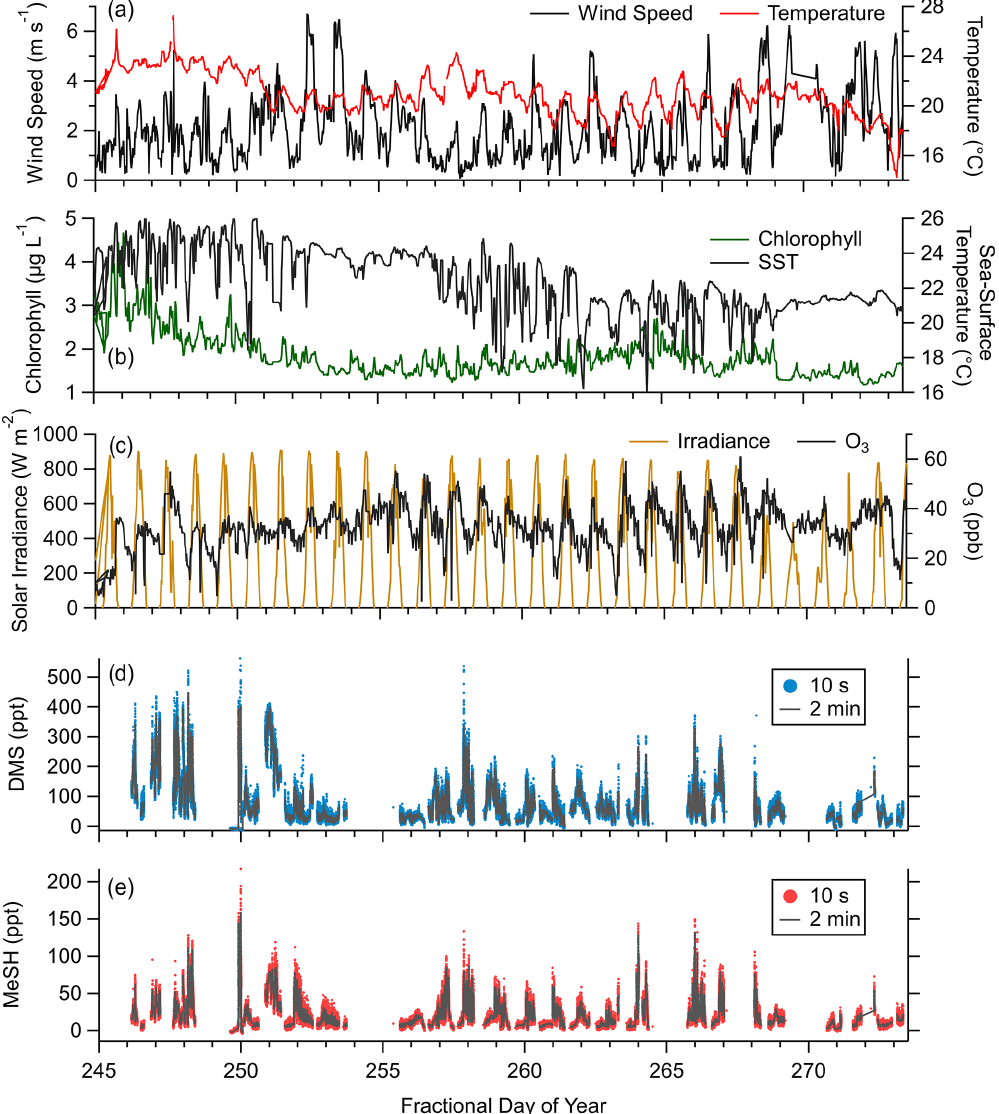
Figure 2. Campaign time series of (a) wind speed and near-surface air temperature, (b) chlorophyll concentration and sea surface temperature (SST), (c) incoming solar irradiance (from 400 to 1100nm) and ozone (O 3 ) mixing ratios, (d) mixing ratios of DMS at 10s and 2min time resolution, and (e) mixing ratios of MeSH at 10s and 2min time